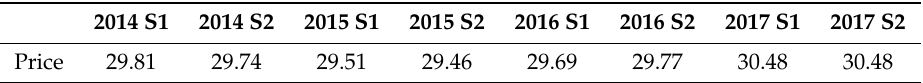
Table 1. Electricity prices for households in Germany from 2014 to 2017, semiannually (in euro cents per